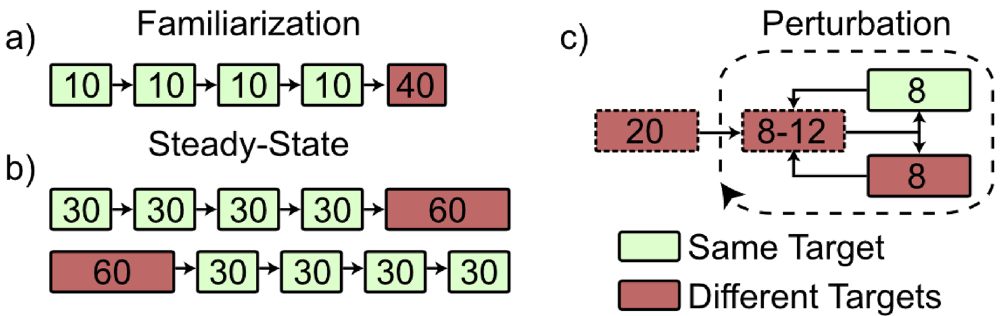
Figure 2. Non-Amputee Experimental Protocol. Subjects completed the experimental protocol twice—once with and once without audio feedback. The order of the feedback and no feedback sessions was randomized across subjects. ( a ) Familiarization involved a total of 80 reaches: four sets of 10 reaches towards each target, and 40 reaches towards targets in balanced random order. ( b ) The steady-state block involved a total of 180 reaches: four sets of 30 reaches towards each target, and 60 reaches towards targets in balanced random order. The order of same- or different-target groupings was randomized across subjects and consistent between subject visits. ( c ) The Perturbation block started with 20 reaches towards targets in random order. After these baseline trials, subjects did cycles of 8–12 reaches towards targets in random order, followed by either 8 reaches towards the same target, or 8 reaches towards targets in balanced random order. The order of these cycles was randomized across subjects and consistent between subject visits. Reaches towards different targets with a dashed border indicate that balanced randomization was not enforced, and the number of reaches towards targets could differ from one